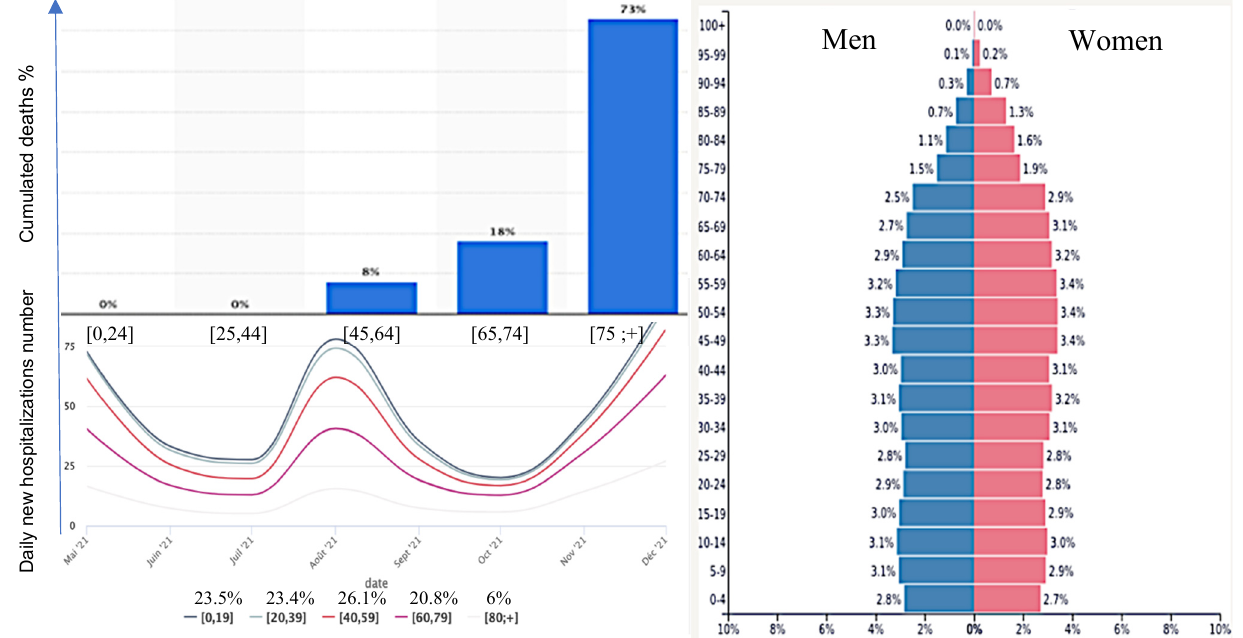
Figure 2. Top left : COVID-19 percentage of death in France by age class [23]. Bottom left : Influence of age (curves with color coding) on COVID-19 hospitalizations in France in the extreme age classes [23]. Bottom right : age classes pyramid in 2020 in France (total population size: 65,273,512) [24].